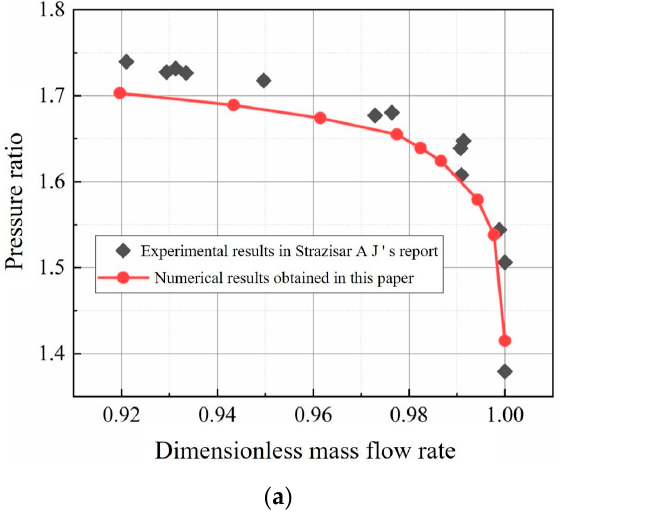
Figure 3. Calculation result veri fi cation of a R67 fan blade. ( a ) Comparison of pressure ratio results; ( b ) Comparison of isentropic e ffi ciency results.